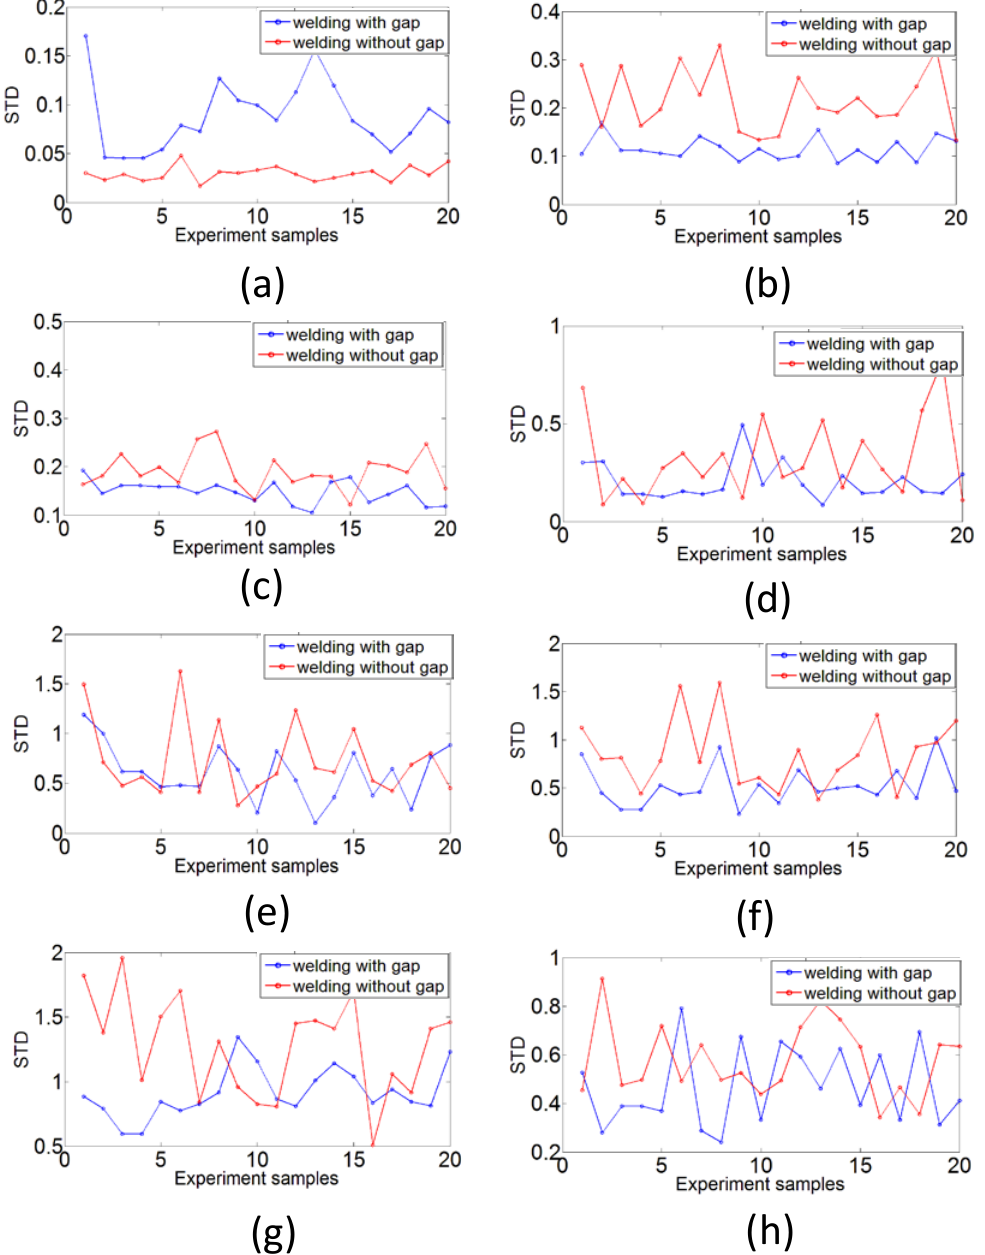
Figure 12. STDs for each selected section with high- and low-joint-bonding strengths: ( a ) first section; ( b ) second section; ( c ) third section; ( d ) fourth section; ( e ) fifth section; ( f ) sixth section; ( g ) seventh section; ( h ) eighth section.